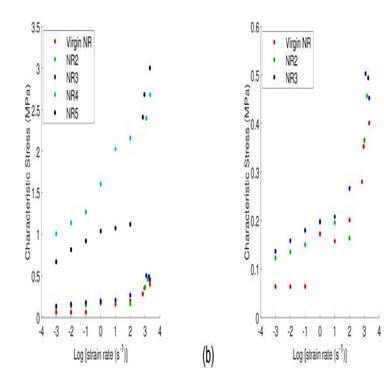
Eyring plots showing 'characteristic' stress vs strain rate at 25 ◦C for (a) all the materials and (b) the three weaker materials.